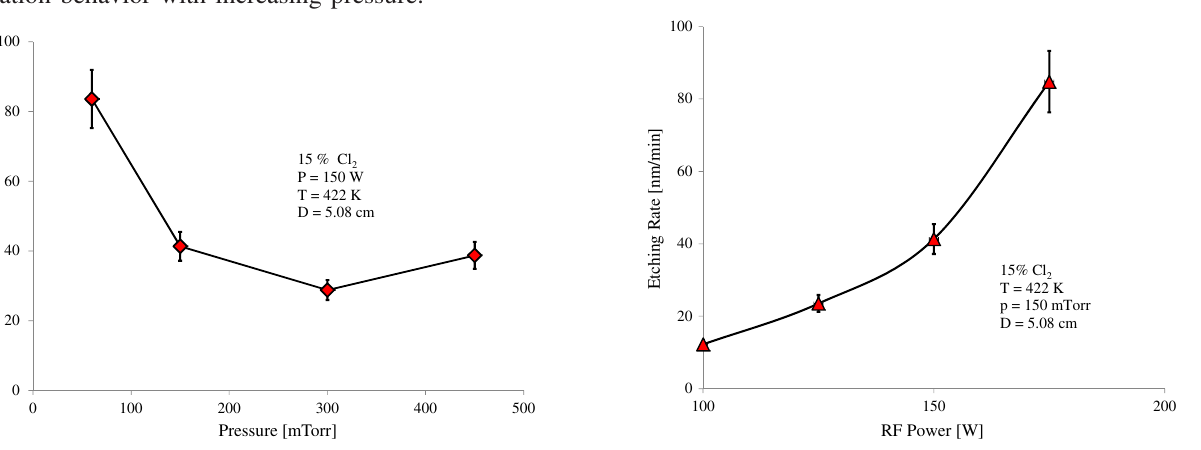
FIG. 9. Etching rate dependence on rf power. Solid line is the exponential